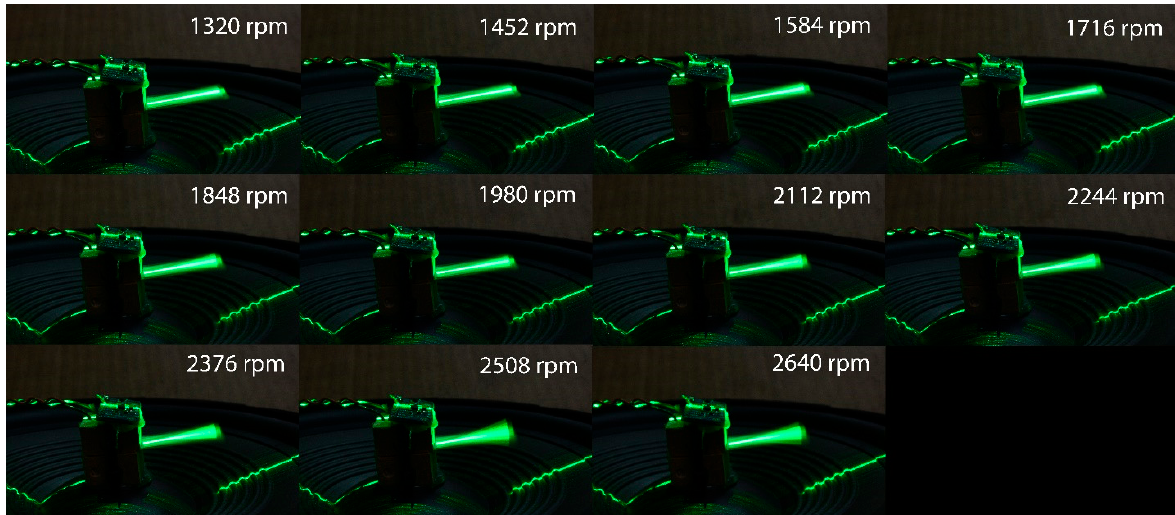
Figure 12. Laser projections of the piezo film with only flow excitation in various fan speeds.